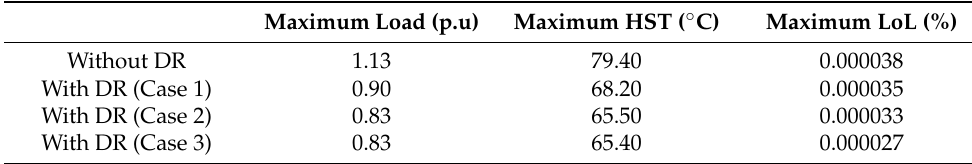
Table 3. Comparison with and without DR.